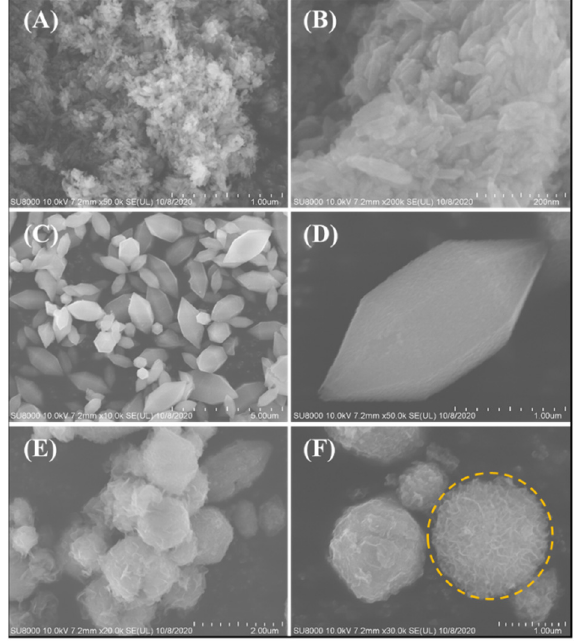
Figure 2. SEM images of ( A , B ) LDHs, ( C , D ) MIL-88A(Fe), and ( E , F ) MIL-88A-LDHs.